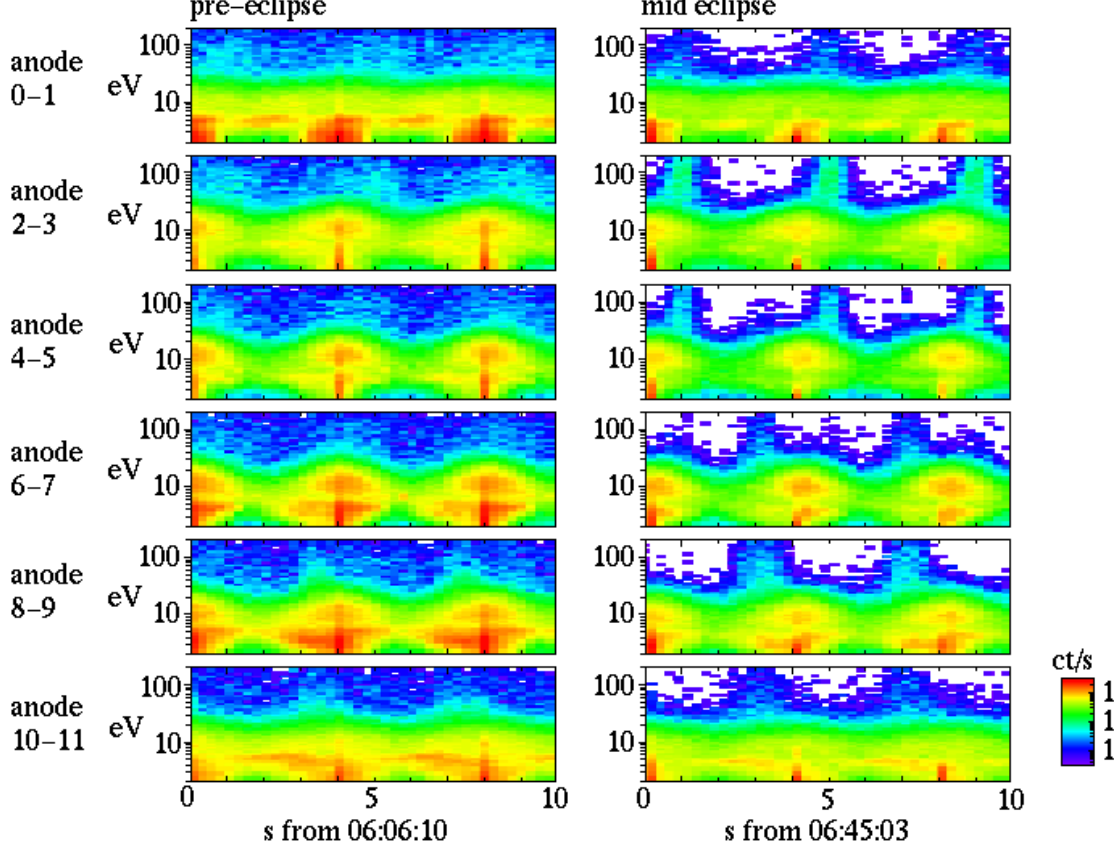
Fig. 8. High resolution 3DX PEACE data showing the structure of the spacecraft electron population in the solar wind before the eclipse (left-hand column) and at mid-eclipse (right-hand column) for each anode